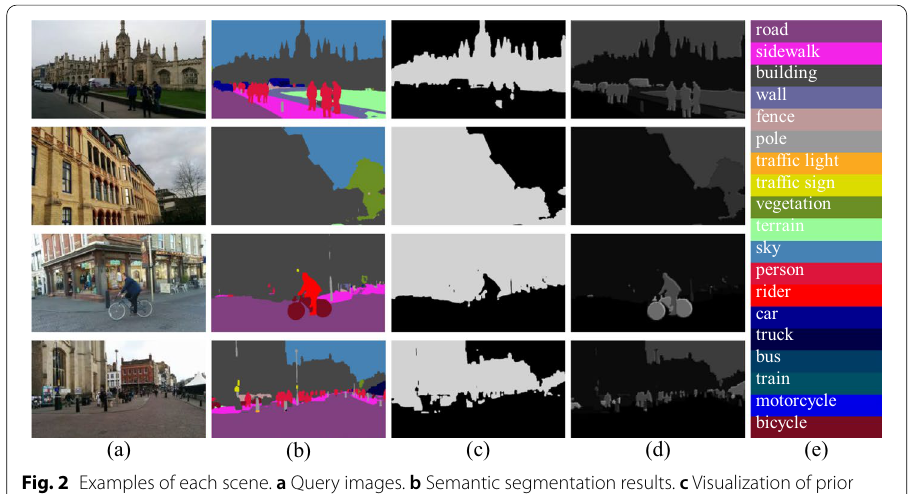
Fig. 2 Examples of each scene. a Query images. b Semantic segmentation results. c Visualization of prior knowledge-based masking. d Visualization of the feature maps S 3 i (second channel) generated by BiasNet. e Colormap of semantic categories for the Cityscapes